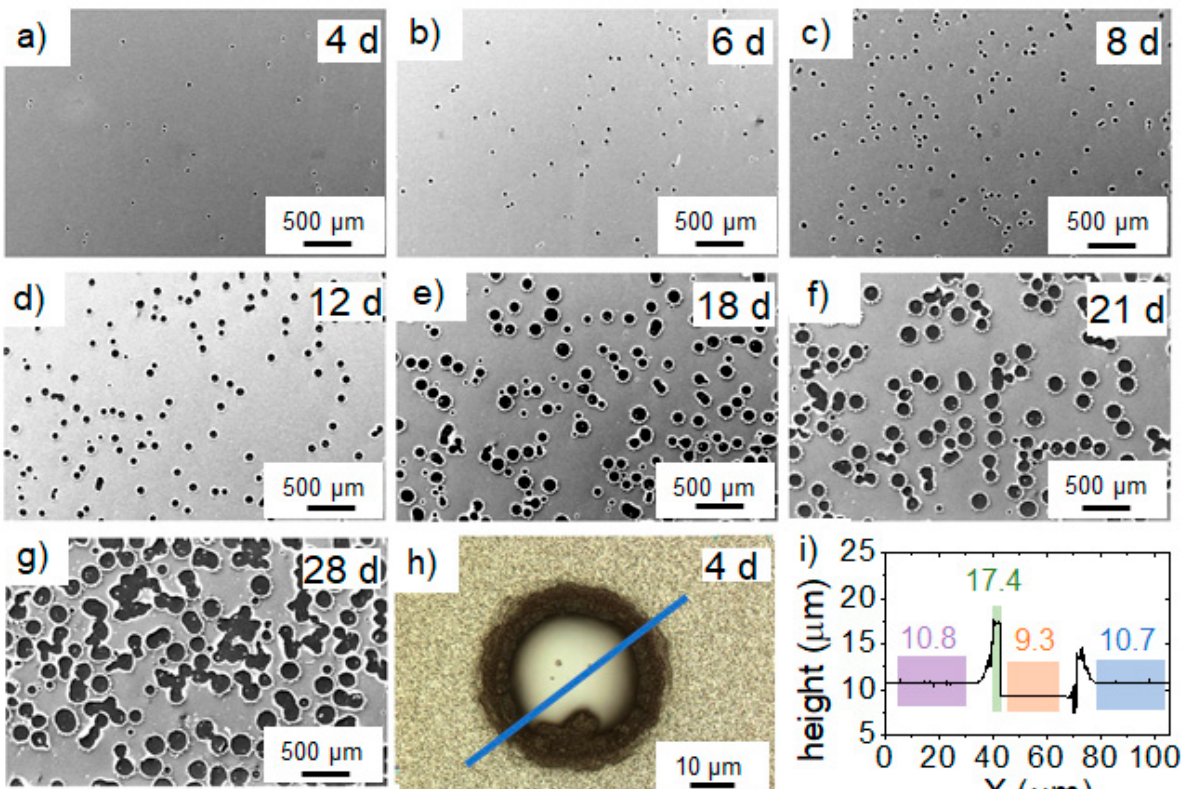
Figure 3. SEM images of Al-capped Ca deposited at 100 °C after exposure times (expressed in days (d)) of ( a ) 4 d, ( b ) 6 d, ( c ) 8 d, ( d ) 12 d, ( e ) 18 d, ( f ) 21 d, and ( g ) 28 d. ( h ) LOM image of a representative surface feature with 150X magnification after exposure time of 4 d. ( i ) LOM height profile across the surface feature in the capped Ca along the blue line depicted in h. The values indicate averaged heights of the marked sections according to the LOM coordinates in μ m. The ridge height (at the crater edge) is around 8 μ m with respect to the substrate (the middle part of the crater marked as orange).